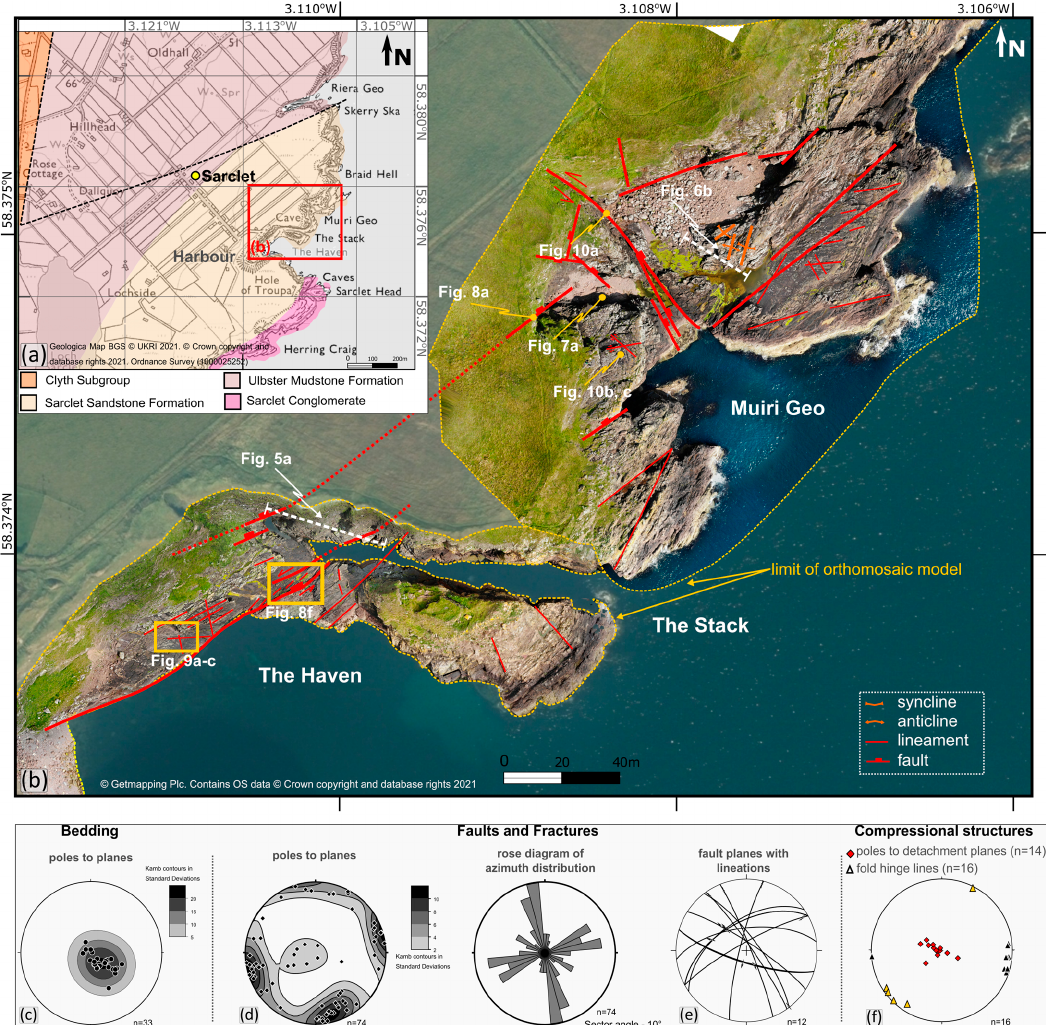
Figure 4. ( a ) Geological map of Sarclet area (using EdinaDigimap service and BGS 1985) showing the location of ( b )—the studied exposure. ( b ) Orthomosaic model obtained from UAV (Unmanned Aerial Vehicle) photography overlapped on aerial map (using EdinaDigimap service © Getmapping Plc) showing the main structural trends. The locations of Figures 5a, 6b, 7a, 8a,f, 9a–c,g and 10a–c are also shown. ( c – f ) Stereonets and rose plots of structural data collected in the field. Lower hemisphere, equal-area projections.